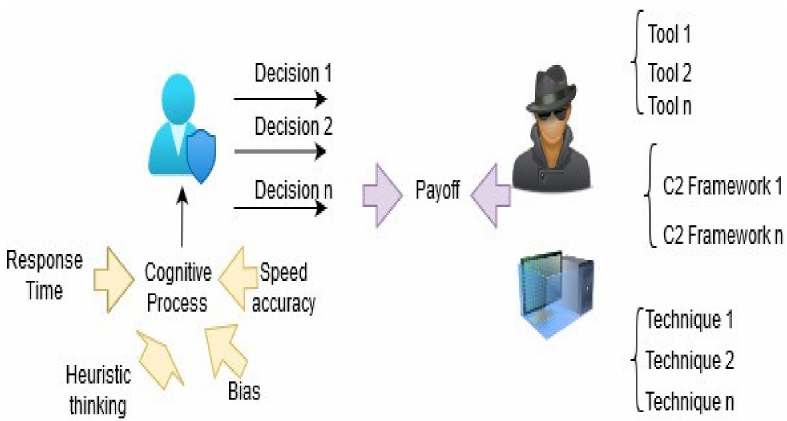
Figure 12. Attack and defense